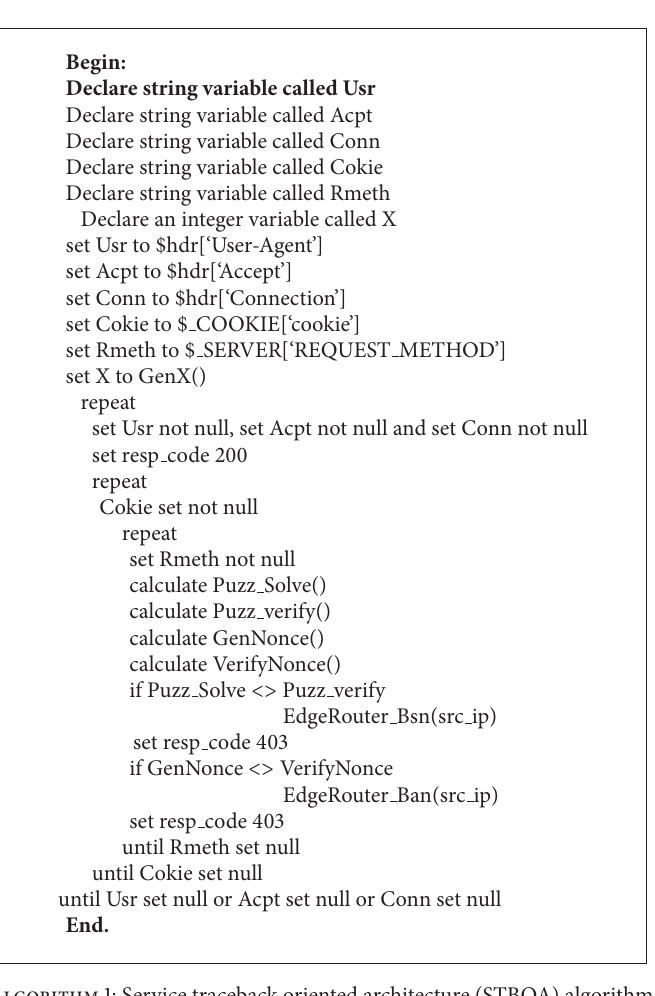
Algorithm 1: Service traceback oriented architecture (STBOA) algorithm.